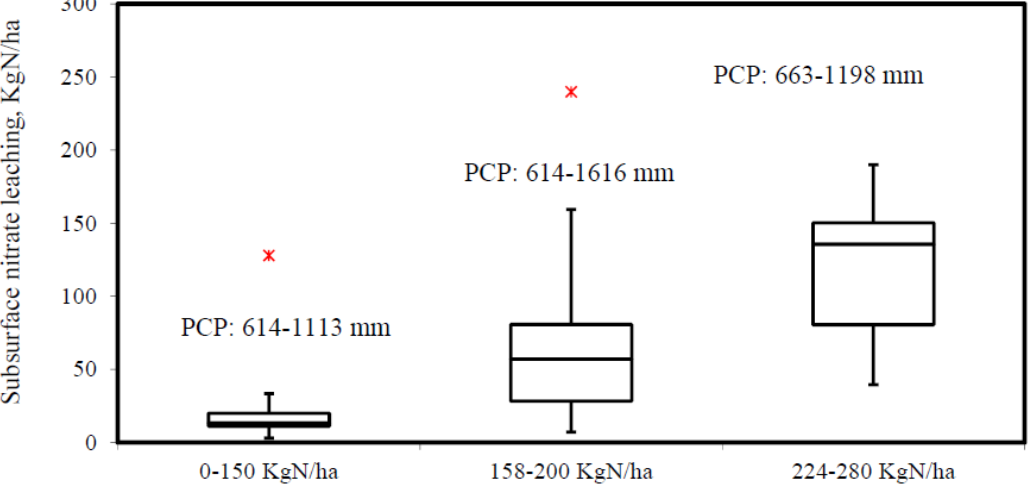
Figure 6. Subsurface nitrogen leaching from loamy sand for continuous corn (seven journal articles were used for analysis).